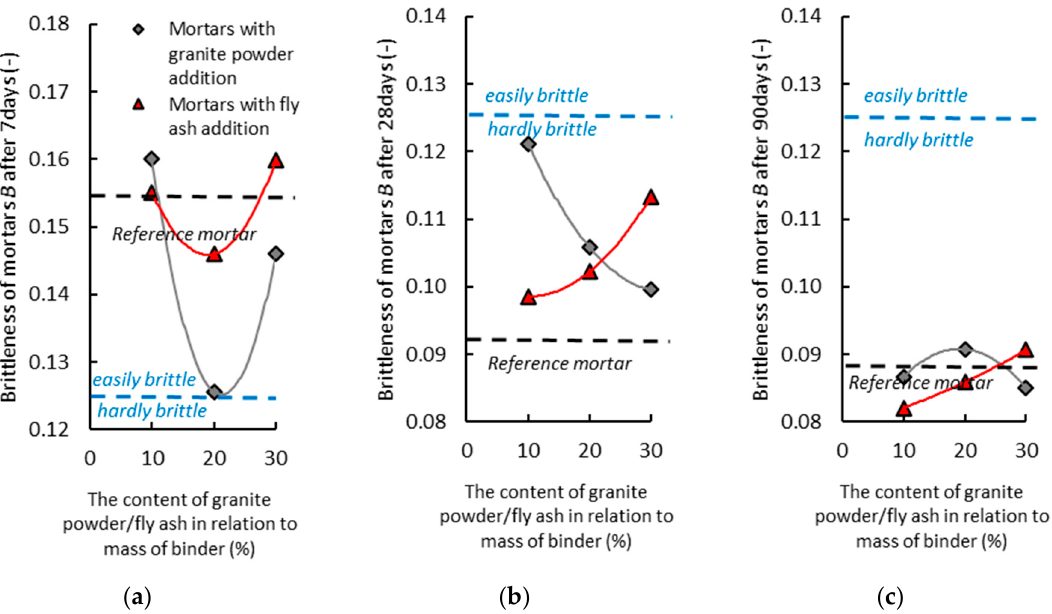
Figure 15. The effect of the amount of cement being replaced with the granite powder or fly ash on the brittleness of the air-cured hardened cementitious mortars: ( a ) after 7 days, ( b ) after 28 days, ( c ) after 90 days.